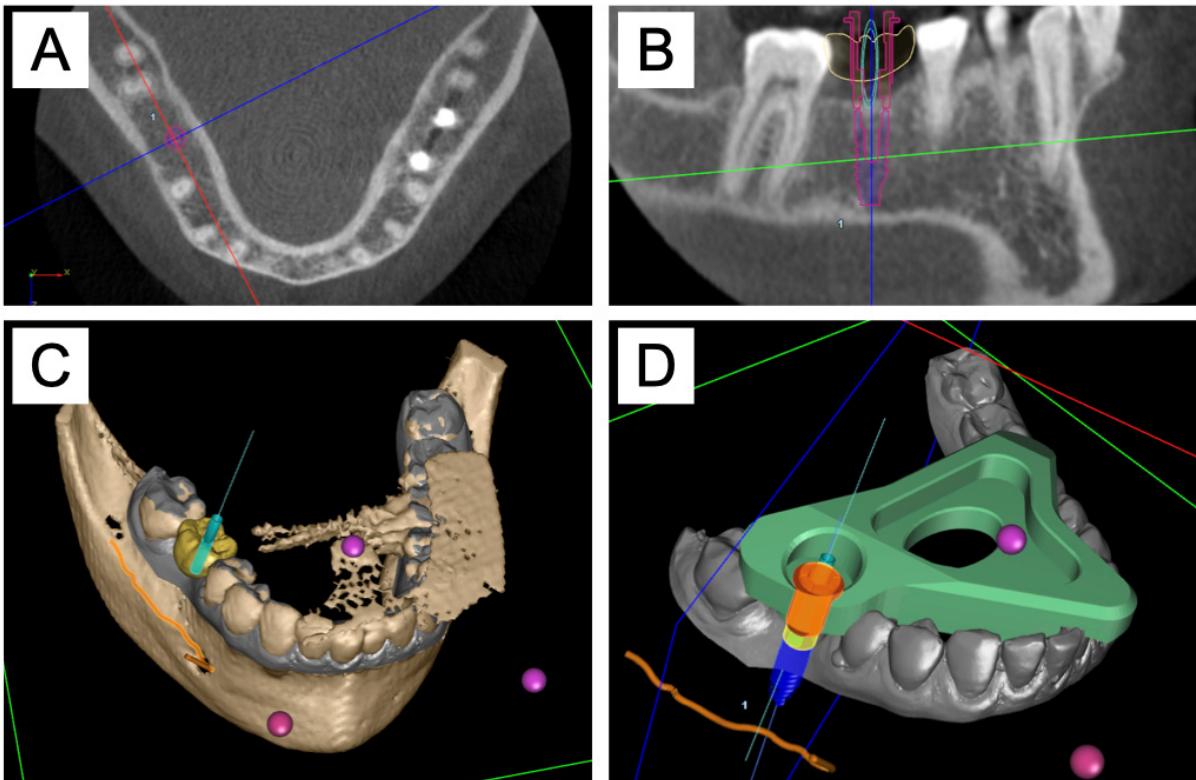
Figure 4. Digital planning software. ( A ) Radiological cross-sectional analysis of the implant site. ( B ) Radiological sagittal analysis of the implant site. ( C ) Digital planning of the screw access hole of an implant-supported single crown. ( D ) Digital planning of the surgical template and the placement of an innovative 8-millimeter-high sleeve.